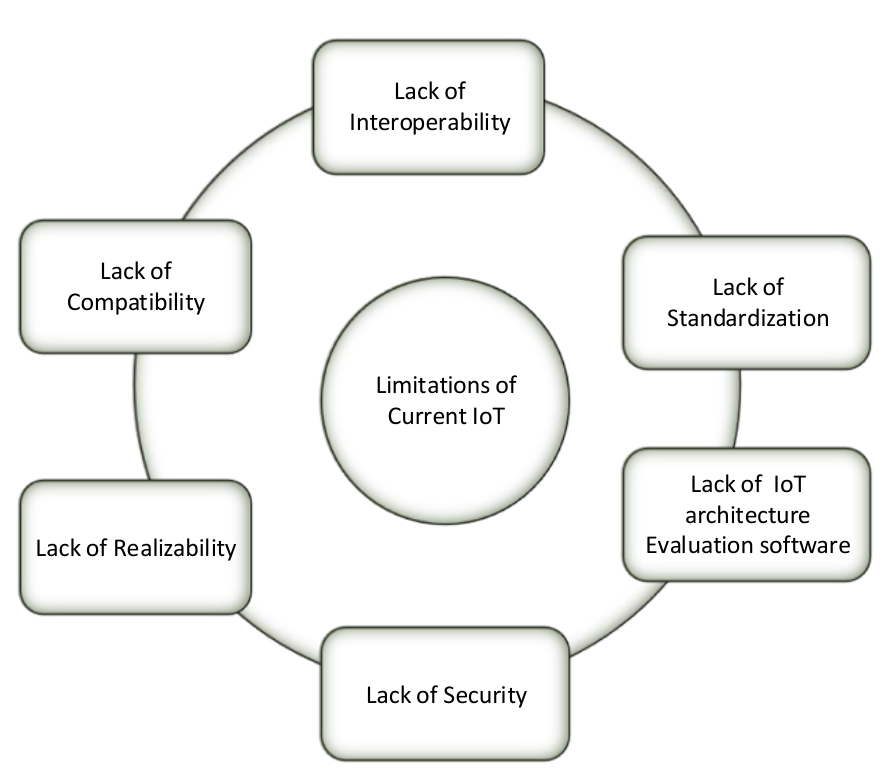
Figure 4. Limitations of current